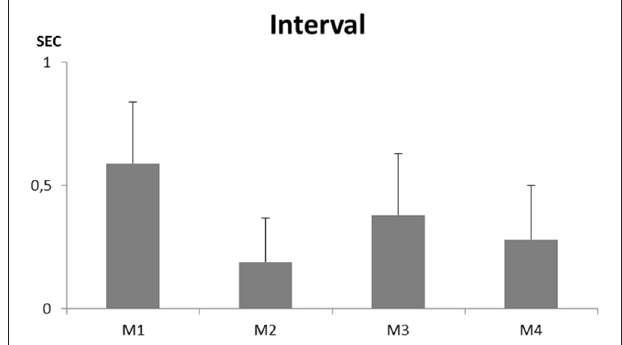
FIGURE 8 | Intermotif intervals recorded for four young male starlings raised without exposure to adult song or contact with adult